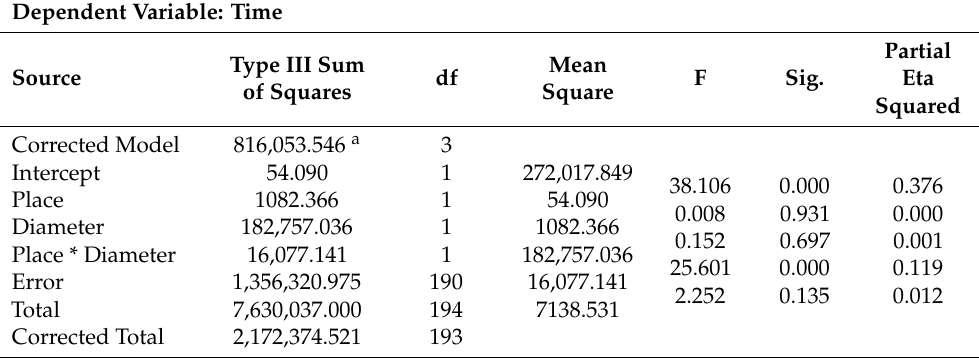
Table 8. SPRUCES—estimates and tests of effect size (place, diameter, place/diameter). Locality—0: Netolice, 1: P í skovna, 2: Rat í škovice.